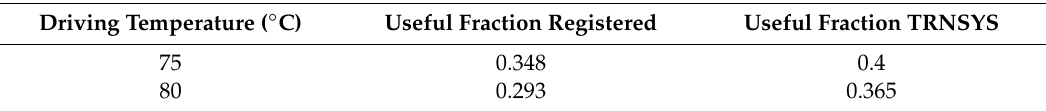
Table 1. Registered and simulated fractions of the incident solar radiation used to drive the absorption chiller for driving temperatures of 75 and 80 ◦ C.